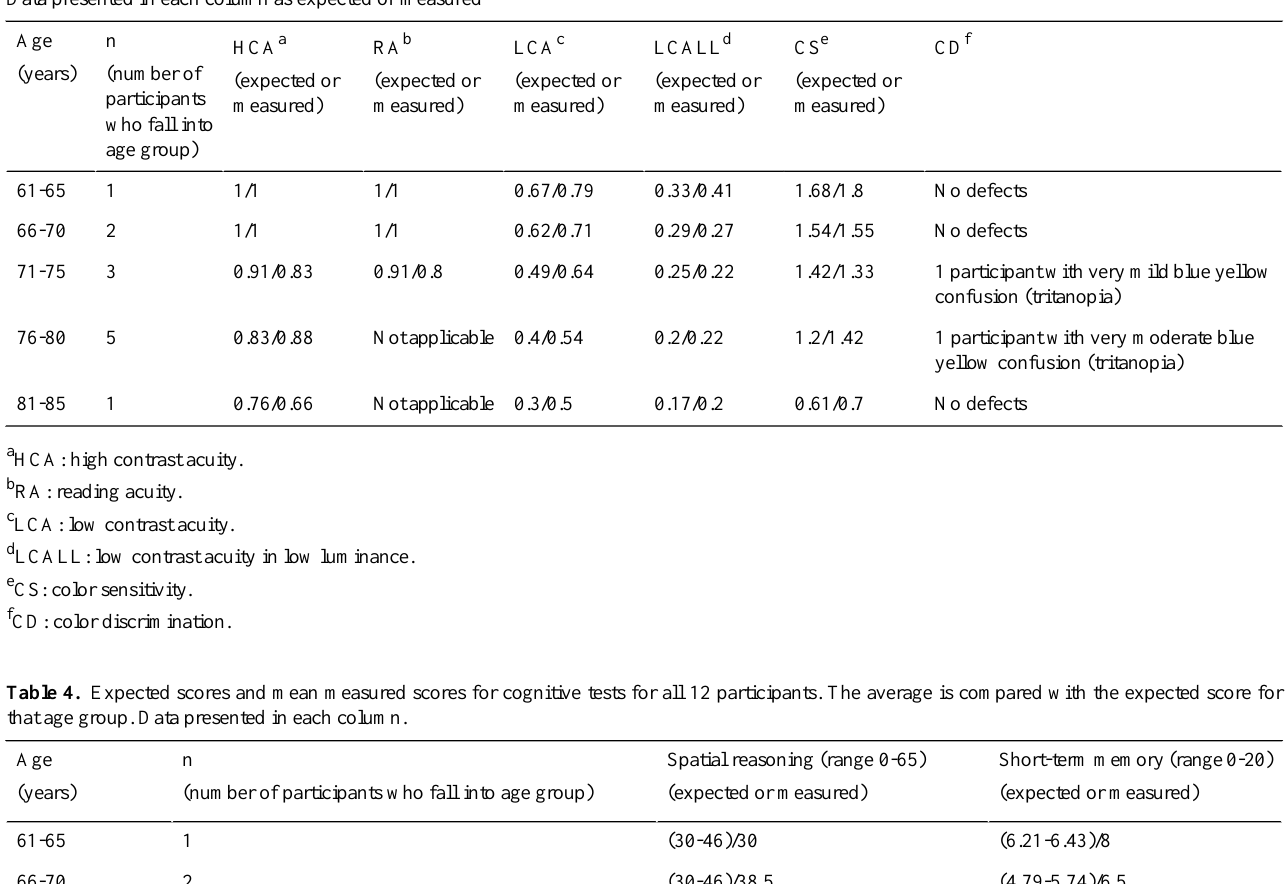
Table 3. Average visual performance metrics measured and split by age group. The average is compared with the expected score for that age group. Data presented in each column as expected or measured